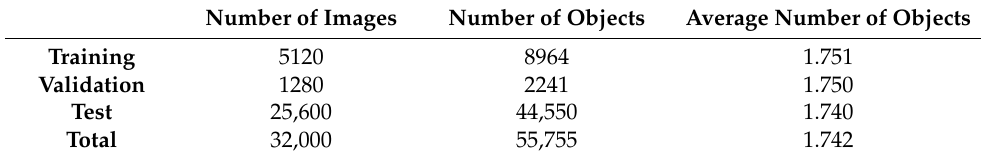
Table 1. The SpotGEO